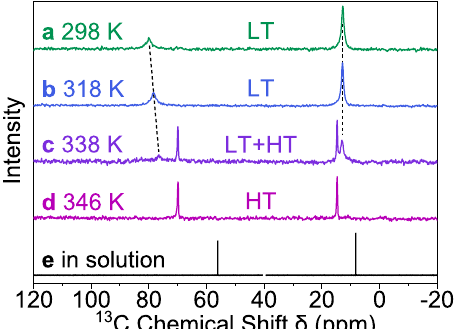
Fig. 3 Solid-state and solution NMR spectra of AthMn(N 3 ) 3 . a – d Solid- state 13 C NMR spectra of AthMn(N 3 ) 3 showing a transition from the low- temperature (LT) to high-temperature (HT) phases. e 13 C NMR spectrum of Ath + in DMSO- d 6 at 298 K with the solvent peak at 40 ppm omitted.